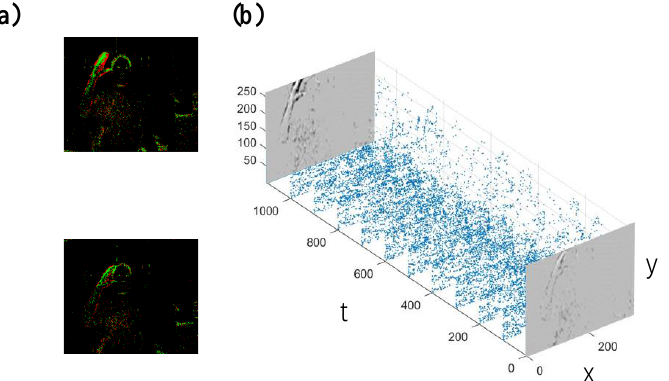
Figure 1. The visualization of DAVIS346 [10] collecting event sign language dataset. ( a ): DVS sensor generates asynchronous event stream when a sign language is posing in front of it; ( b ): continuous raw events between two consecutive grayscale images from an event